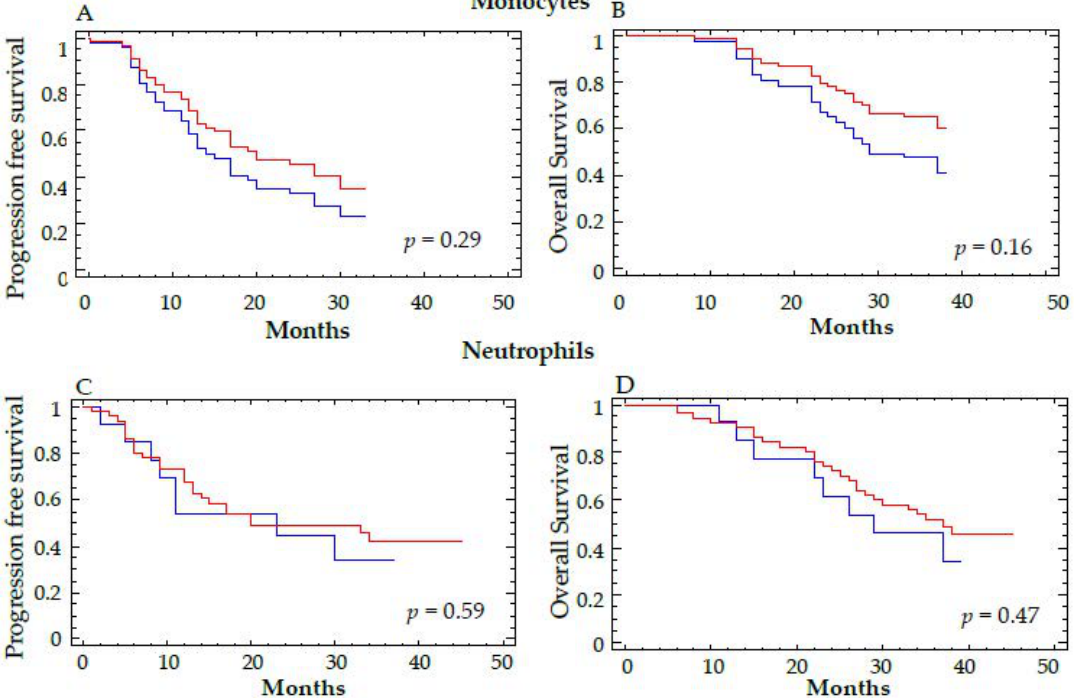
Figure 6. Correlation between the decrease in total monocytes and neutrophils and clinical out- come. The total number of monocytes ( A , B ) and neutrophils ( C , D ) were determined by automatic hematologic count before (T1) and at the end of anti-angiogenic therapy (T3). A cutoff of 20% for the percent decrease of monocytes and neutrophils was considered to separate the two groups of patients. Progression-free survival ( A , C ) and overall survival ( B , D ) are represented. Log-rank test was used for the statistical analysis. The red curve corresponds to a decrease in the total number of monocytes ( A , B ) or neutrophils ( C , D ) >20% and the blue curve to a decrease ≤ 20% for these 2 parameters between